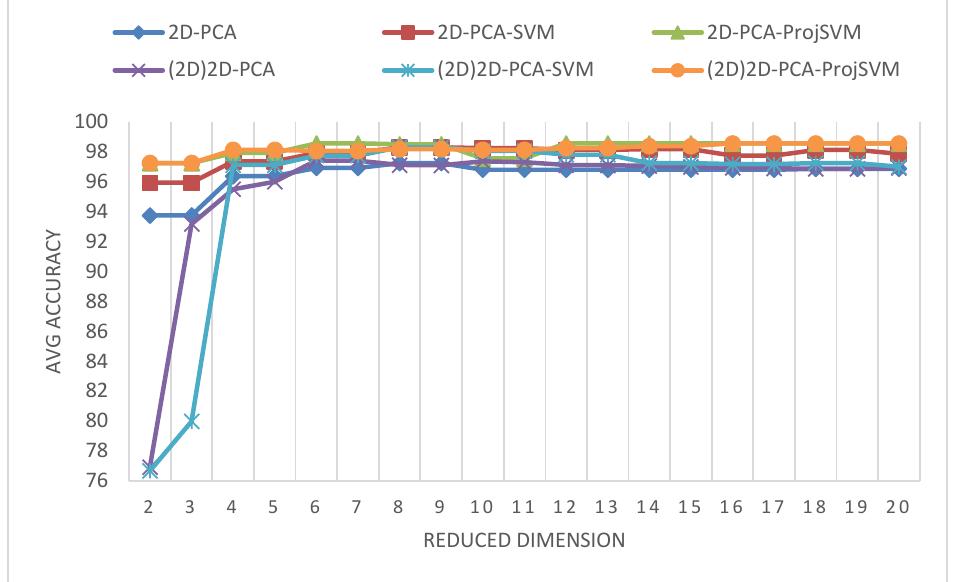
Figure 1. Average accuracy versus reduced dimension for six methods on ORL dataset with PCA-based methods.